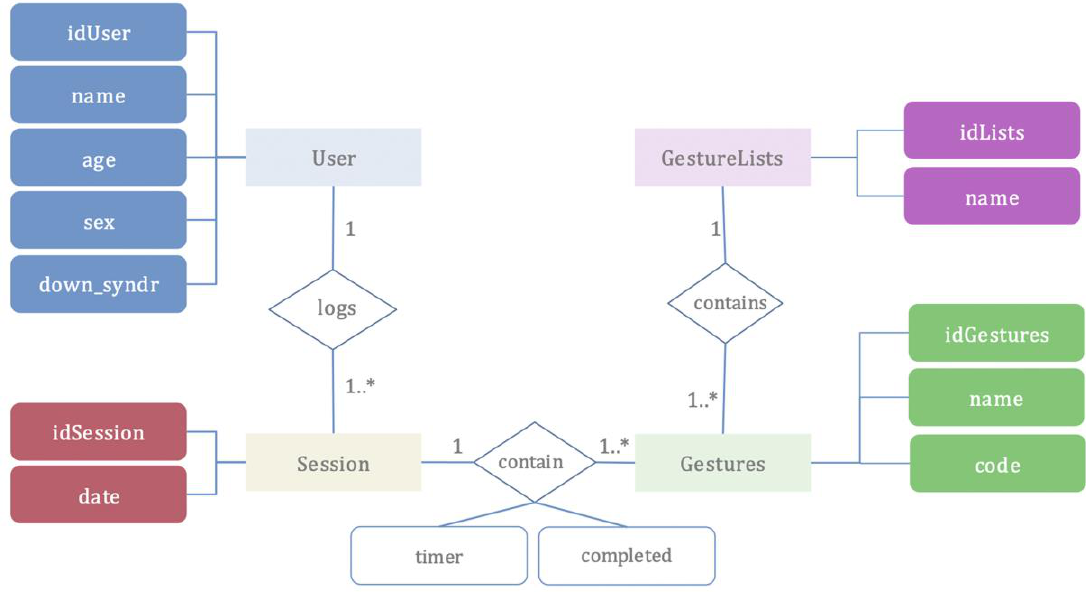
Figure 4. Entity Relationship Diagram (ERD): Database.